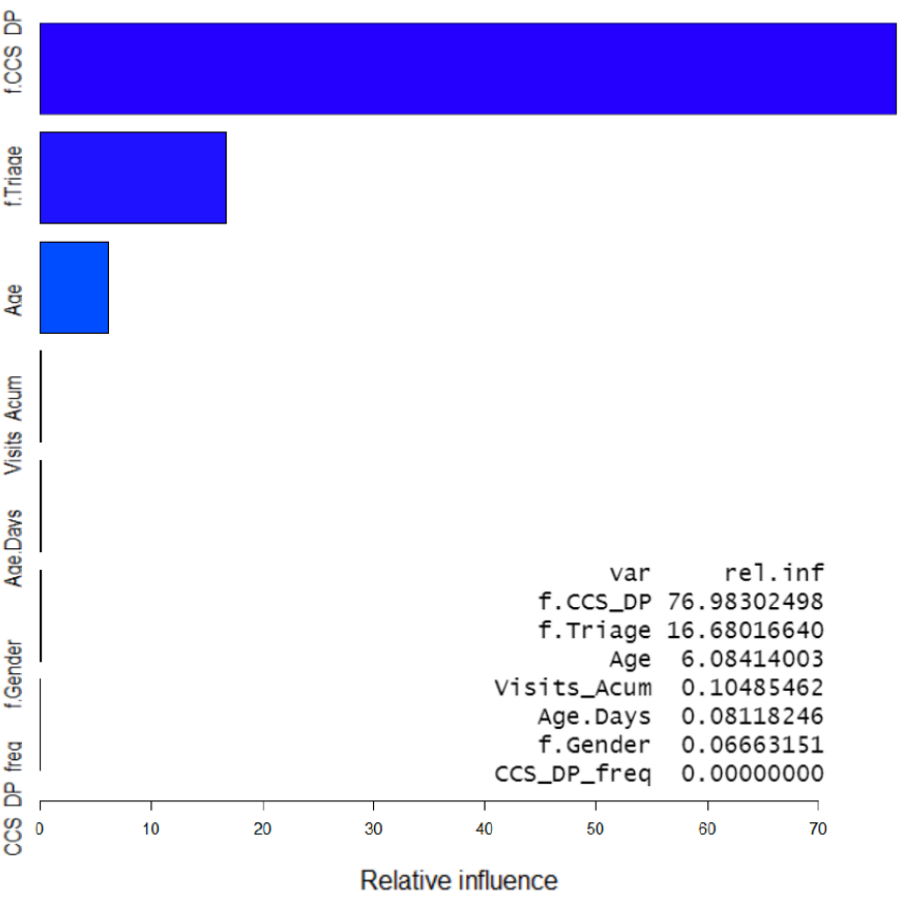
Figure 5. Variable